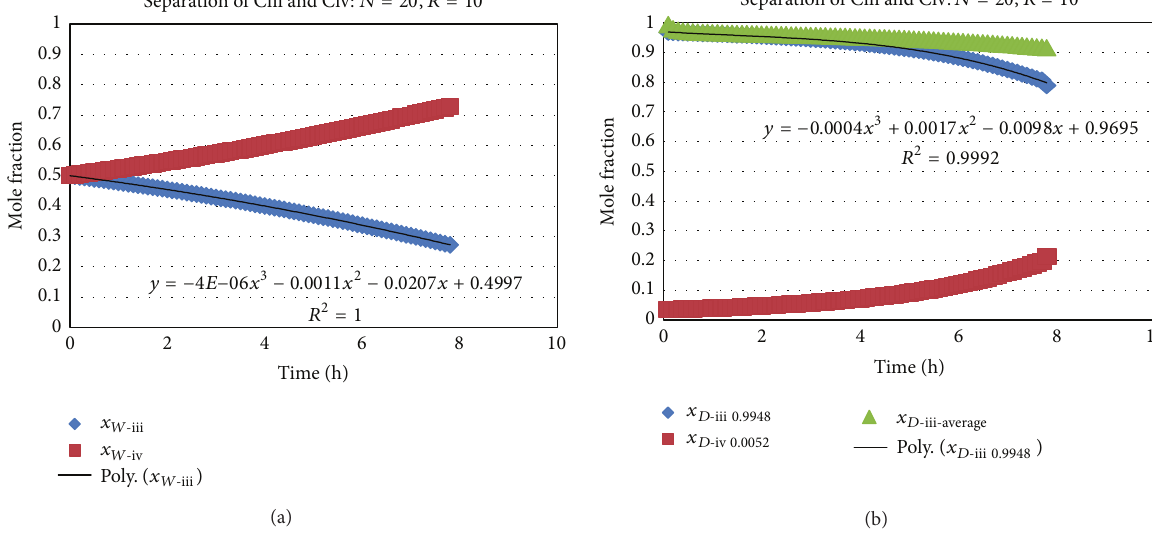
Figure 5: Results for two components (ethylbenzene and o-xylene) batch distillation at 𝑁 = 20 and 𝑅 = 10